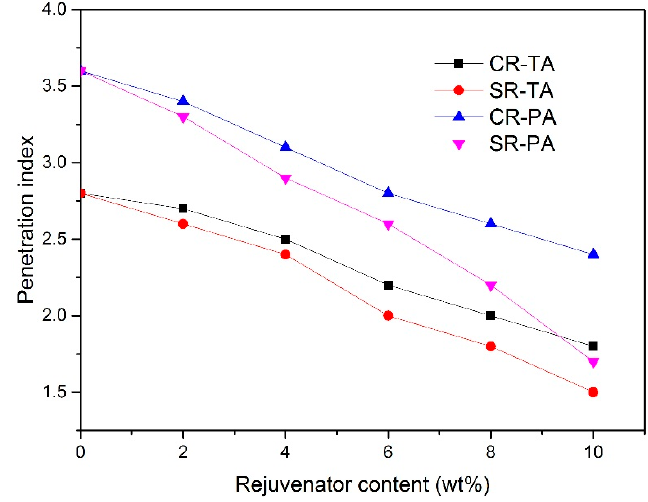
Figure 3. PI of regenerated bitumen with different rejuvenators.